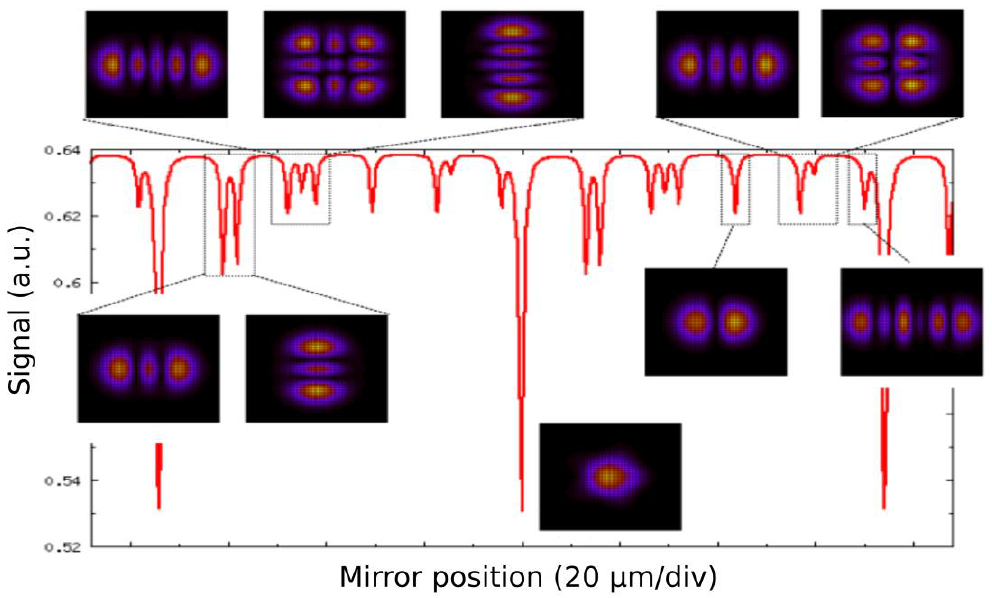
Figure 2. Simulation of the bow tie cavity (BTC) spectrum, showing contributions from higher-order transverse modes. Table 1. Main parameters calculated for the bow-tie cavity, in comparison with the ones for the V- shaped and ring cavities [20] (FSR: Free spectral range). All parameters are calculated in vacuum, apart from column F air reporting the finesse values taking into account the water vapor absorption coefficient of ~0.0038 cm −1 [20].